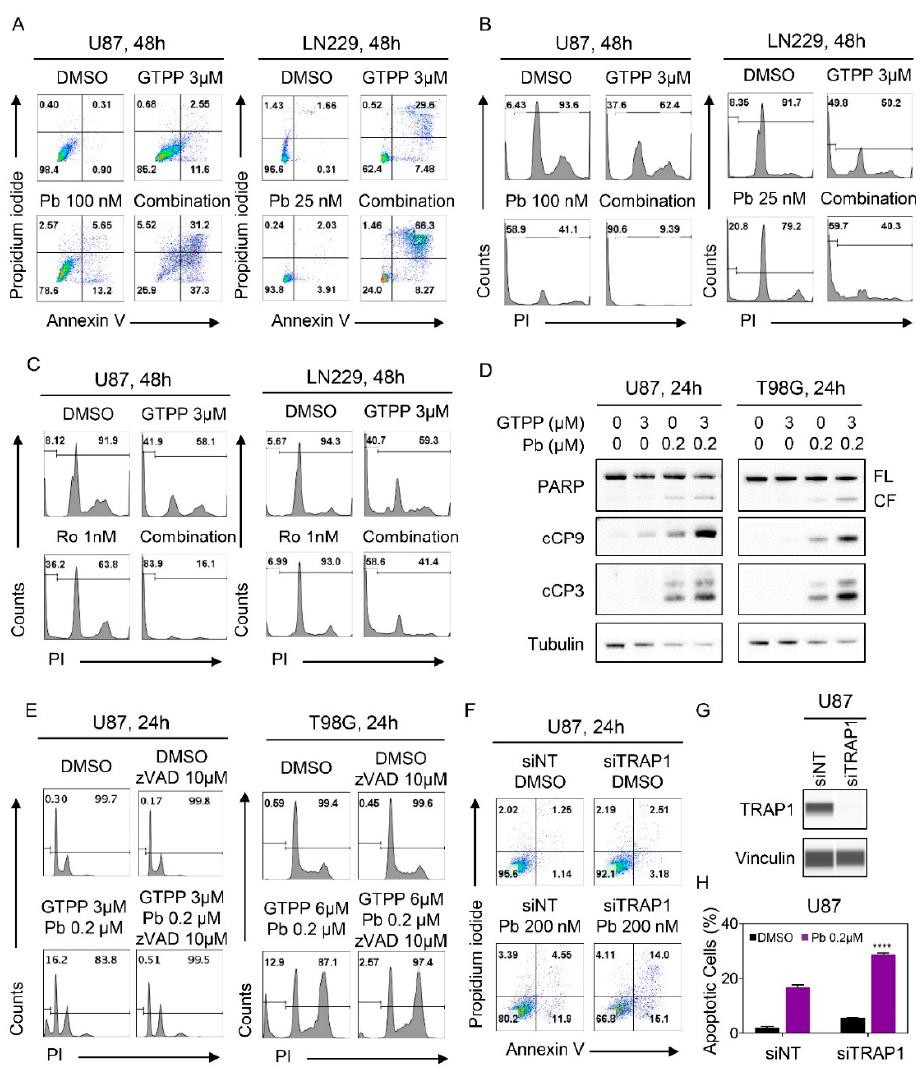
Figure 2. Combined inhibition of TRAP1 and HDACs enhanced activation of a cell death with apoptotic features, including cleavage of caspases. ( A ) U87 and LN229 cells were treated with the indicated concentration of gamitrinib, panobinostat or the combination of both for 48h. Thereafter, cells were labeled with annexin / propidium iodide (PI) dye and analyzed by multi-parametric flow cytometry. Shown are representative flow plots; ( B , C ) U87 and LN229 cells were treated with the indicated concentrations of gamitrinib, panobinostat / romidepsin or the combination of both for 48h. Thereafter, cells were labeled with propidium iodide (PI) dye and analyzed by flow cytometry. Shown are representative flow plots; ( D ) Standard western blots of cell lysates of U87 and T98G treated with gamitrinib, panobinostat or the combination of both for 24h. Tubulin is used as a loading control. FL: full length, CF: cleaved fragment; ( E ) U87 and T98G cells were treated with the combination treatment of gamitrinib and panobinostat in the presence or absence of zVAD for 24h. Thereafter, cells were labeled with propidium iodide (PI) dye and analyzed by flow cytometry. Shown are representative flow plots; ( F – H ) U87 GBM cells were transfected with scrambled or TRAP1 specific siRNA and treated with panobinostat for 24h. Knockdown e ffi ciency was confirmed by protein capillary electrophoresis. Vinculin serves as a loading control. Thereafter, cells were labeled with Annexin / PI dye and analyzed by multi-parametric flow cytometry ( n = 3). Shown are means and SD. Statistical significance was determined by two-tailed Student’s t -test. **** p < 0.001. Finally, we asked whether the combination treatment would display enhanced cleavage/activation of caspases and caspase substrate cleavage, respectively. While panobinostat